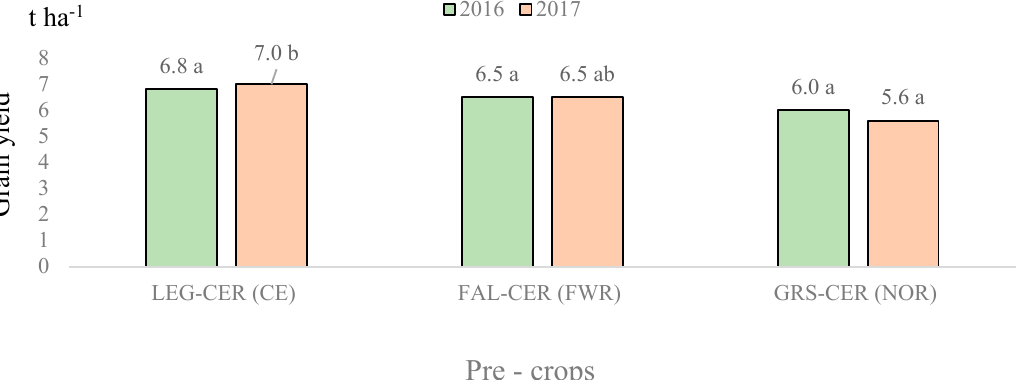
Figure 4. Winter wheat productivity after the use of various pre-crops in different crop rotations in 2016 and 2017. Note: a,b indicate significant differences between the treatments ( p ≤ 0.05). FAL- CONTROL, continuous bare fallow; LEG-CER (CE), winter wheat pre-crop was a vetch and oat mixture for green forage while the crop rotation was cereal; FAL-CER (FWR), winter wheat pre-crop was black fallow while the crop rotation was field with row crops; GRS-CER (NOR), winter wheat pre-crop was a clover–timothy mixture while the crop rotation was Norfolk.